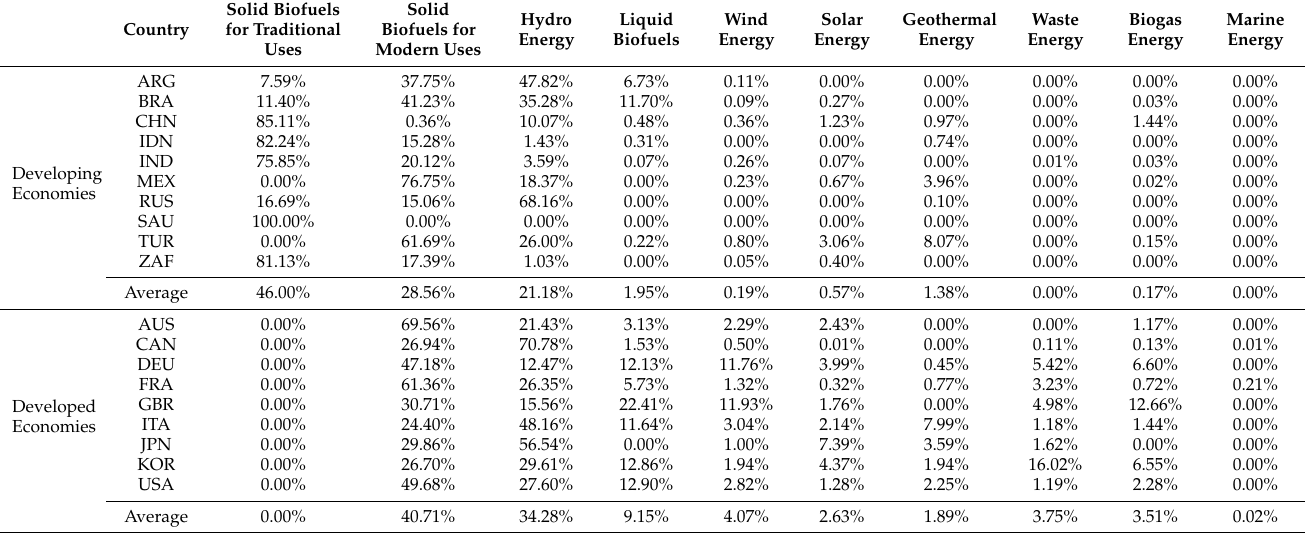
Table 2. The percentage of different types of renewable energy for all G20 economies in